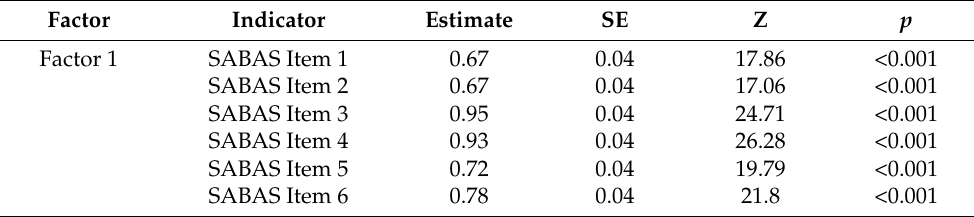
Table 5. Confirmatory factor analysis of the Smartphone Application-Based Addiction Scale.